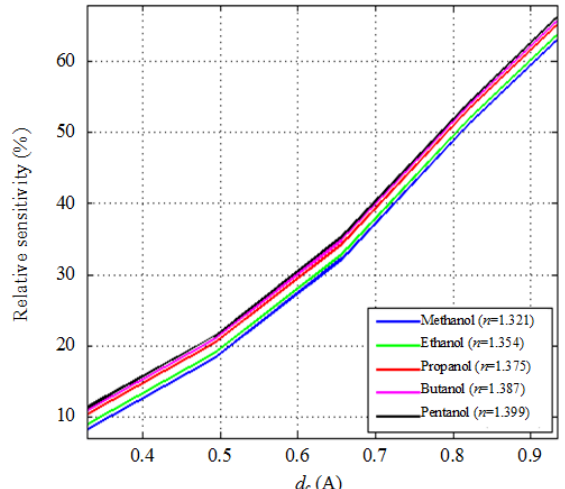
Fig. 6 Comparison of relative sensitivity with core air filling ratio ( d c /  ) variations for alcohol